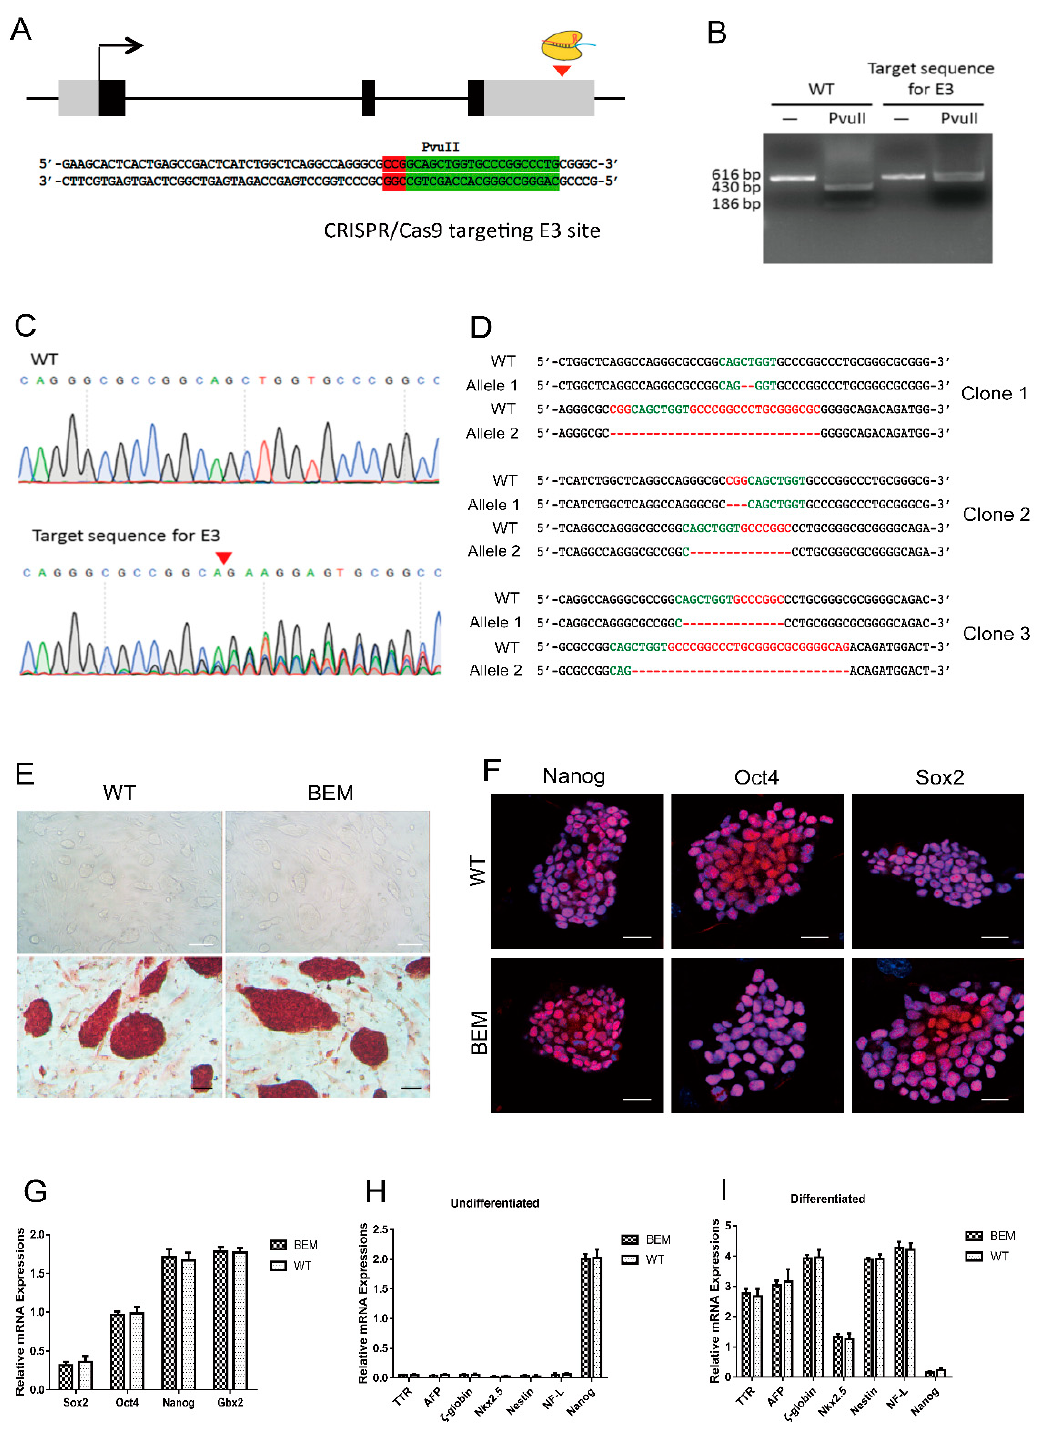
Figure 3. Generation and characterization of Barhl1 E3-box mutated (BEM) mouse embryonic stem cell (mESC) lines. ( A ) Schematic diagram showing the position of target site of CRISPR / Cas9 in the Barhl1 E3 site. Gray / black boxes, exons; black boxes, Barhl1 coding sequence (CDS); solid line between black boxes, introns; black arrow, direction of transcription; red arrowheads, indicating target sites of CRISPR / Cas9 in the Barhl1 E3 site. Sequence of target sequence for the E3 site (indicated by green) carrying a cleavage site of PvuII and the protospacer adjacent motif (PAM, indicated by red) were displayed in detail. ( B ) Restriction digestion of 616bp polymerase chain reaction (PCR) product of the E3 site by PvuII. The WT E3 site instead of the mutated E3 site can be digested into 430 and 186 bp. PCR products without enzymatic digestion were used as controls. ( C ) The sequencing peak map of